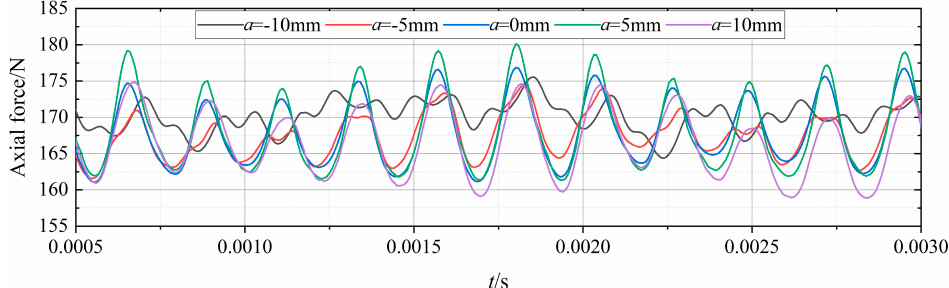
Figure 17. Axial force–time domain distribution under near-blockage conditions.